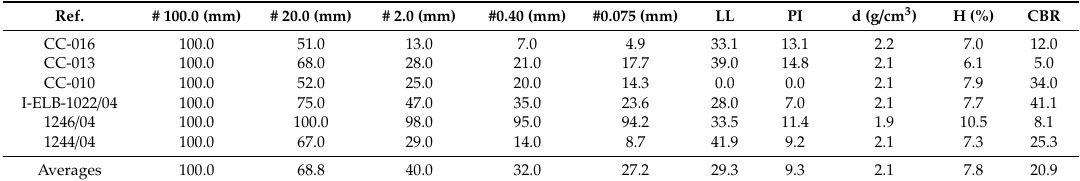
Table 2. Examples of physical parameters for slate alluvial material identification. Ref.